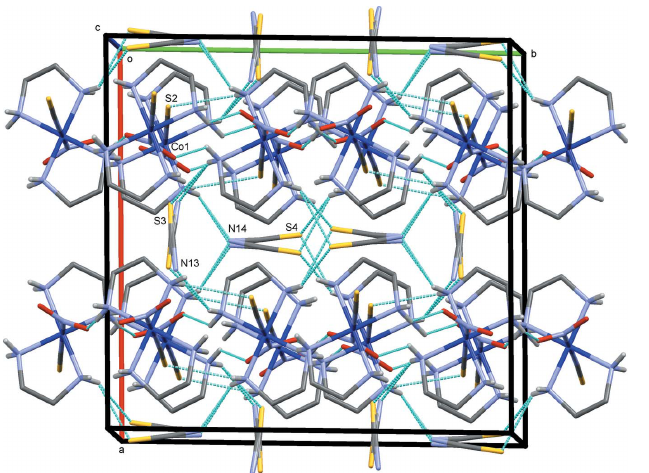
Figure 4 The crystal structure of (I), projected along c . N—H (cid:2)(cid:2)(cid:2) O/N/S hydrogen bonds are shown as blue dashed lines. Both possible orientations of the disordered thiocyanate ions are indicated.